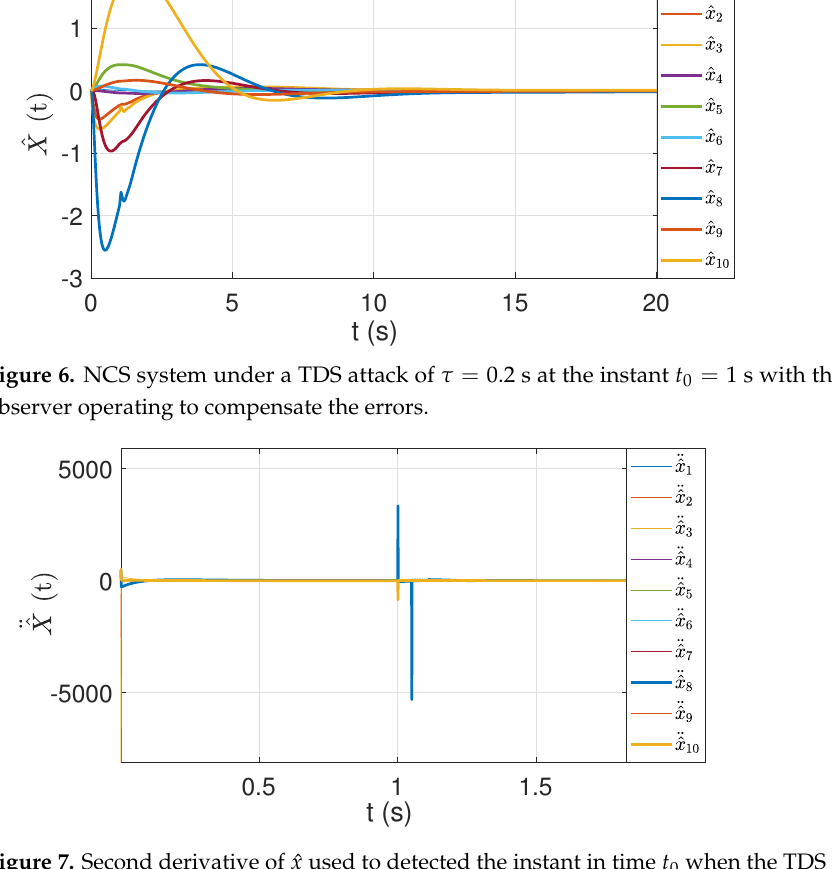
Figure 7. Second derivative of ˆ x used to detected the instant in time t 0 when the TDS is deployed. The simulation was repeated with different time delays inserted by the TDS attack into the NCS at different starting instants ( t 0 = 1, 2, ..., 5 seconds). Table 3 shows the results for three different time delays τ . The results show an Mean Square Error (MSE) around 5%. Table 3. Delay estimation